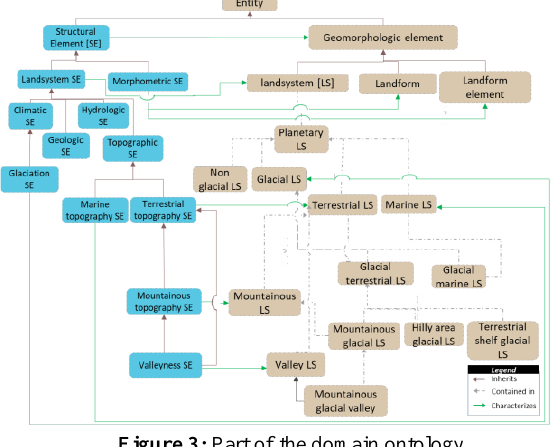
Figure 3: Part of the domain